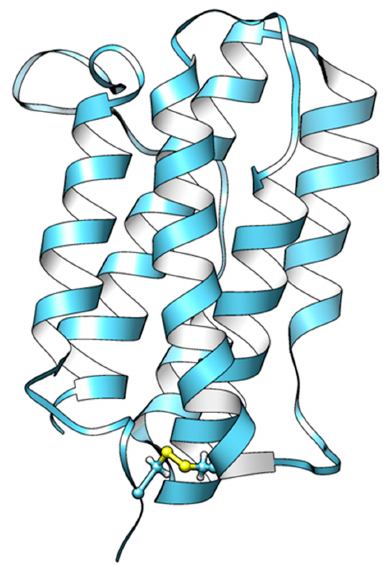
Figure 2. Protein model of the type I IFN- α from E. septemfasciatus . The IFN- α model was built based on the 3D structure of the interferon 1 from Danio rerio (PDB 3PIV) by using Chimera and